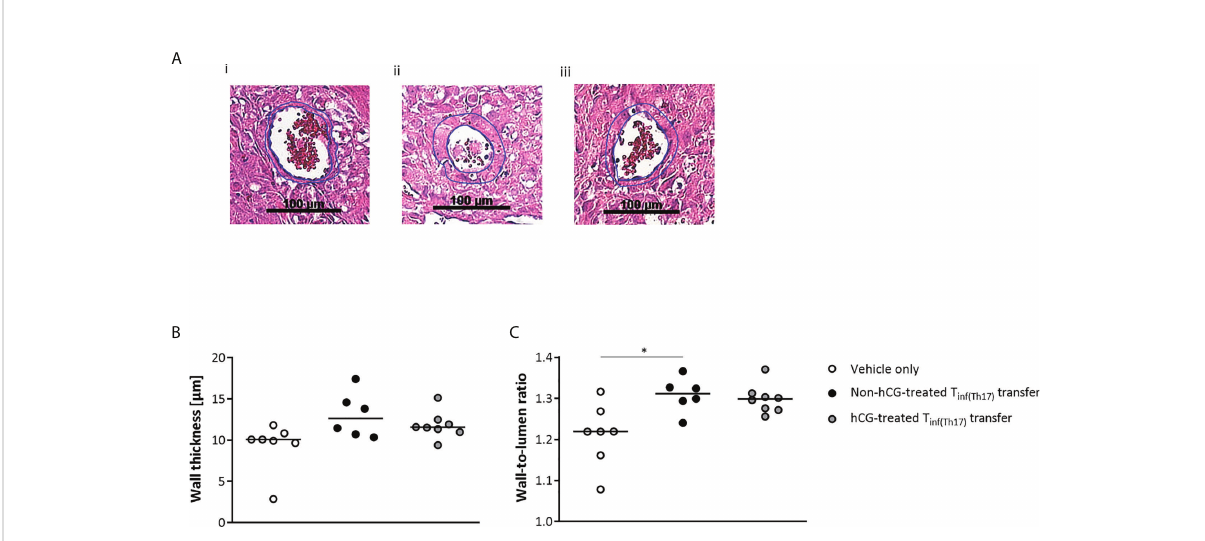
FIGURE 9 Adoptive transfer of T inf(Th17) cells impaired vascular remodeling in the uSAs. Naïve CD4 + T cells were isolated by magnetic-activated cell sorting (MACS), polarized into Th17 cells under Th17-differentiating conditions for 3 days in vitro , in the presence or absence 500 mIU/ml rhCG, and then injected into pregnant CBA/J females during the fi rst 2 days of gestation. (A) Examples of hematoxylin – eosin staining of sections through individual uSAs in the decidua basalis of animals in the vehicle-only ( n = 7) (i), non-hCG-treated ( n = 6) (ii) and hCG-treated ( n = 8) (iii) groups on gd 12, viewed at a magni fi cation of 200×. (B) Medial uSA wall thickness, calculated from 3 – 8 uSAs per animal. (C) Medial uSA wall-to-lumen ratio, calculated from 3 – 8 uSAs per animal. Data are presented as medians, with individual values for each animal. For comparisons between experimental groups, the Kruskal – Wallis test followed by Dunn ’ s multiple-comparison test was used. Following, medians are provided for signi fi cant differences between groups for the wall-to-lumen ratio: 1.219 vs 1.312 (vehicle only vs non-hCG-treated Th17 cells). * indicates p < 0.05. uSA, uterine spiral